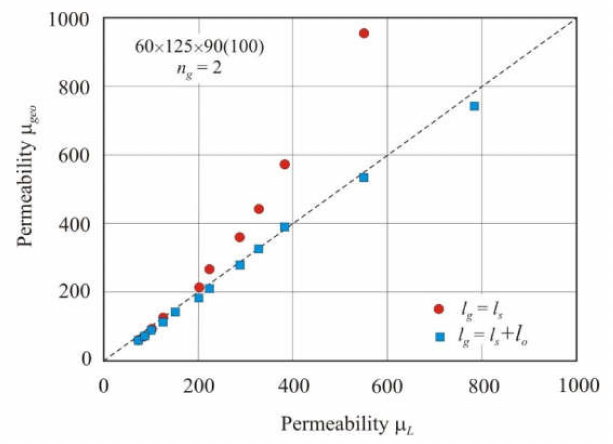
Figure 11. Relationship of geometric permeability µ geo and measured permeability µ L in a 60 × 125 × 90 (100) rectangular core with two air gaps. The total air gap length l g was taken equal to l s or ( l s + l o ), where l s is the spacer thickness, and l o is the residual air gap length. The dashed line corresponds to equation µ geo = µ L